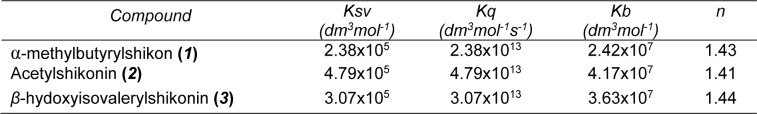
Quenching constant (KSV), the quenching rate constants (Kq), binding constant (Kb), and number of binding sites (n) for naphthoquinone-HAS interactions